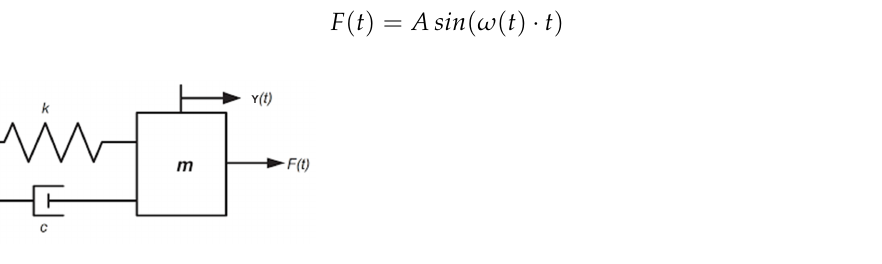
Figure 3. Damped forced vibration